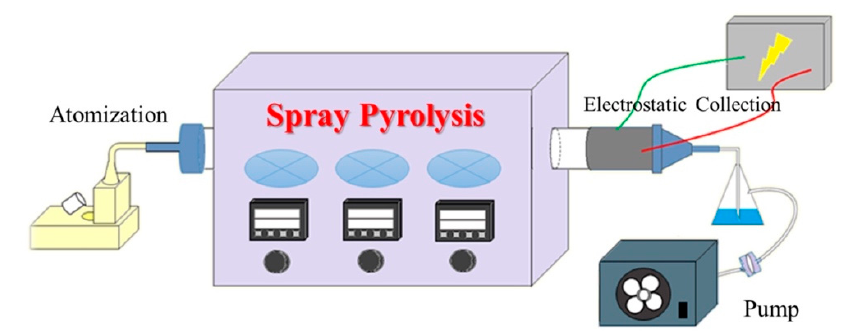
Figure 1. Spray pyrolysis (SP) process device diagram.